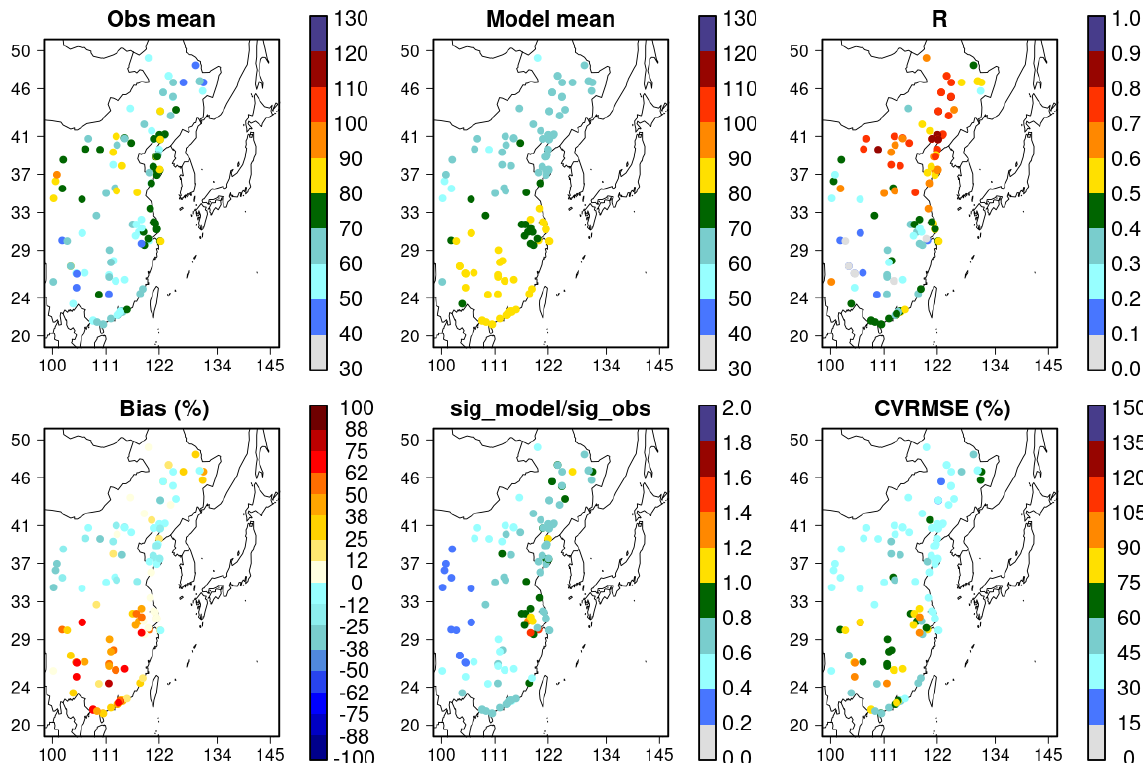
Figure A1. Mean daily O 3 concentrations (in micrograms per cubic metre) observed at the rural-type Chinese stations and simulated by INCA for 2014–2017. The statistics of the comparison at each station is shown with the correlation coefficient ( R ), the mean bias, the ratio of the standard deviation of the model and the observations, and the coefficient of variation of the root mean square error (CVRMSE).